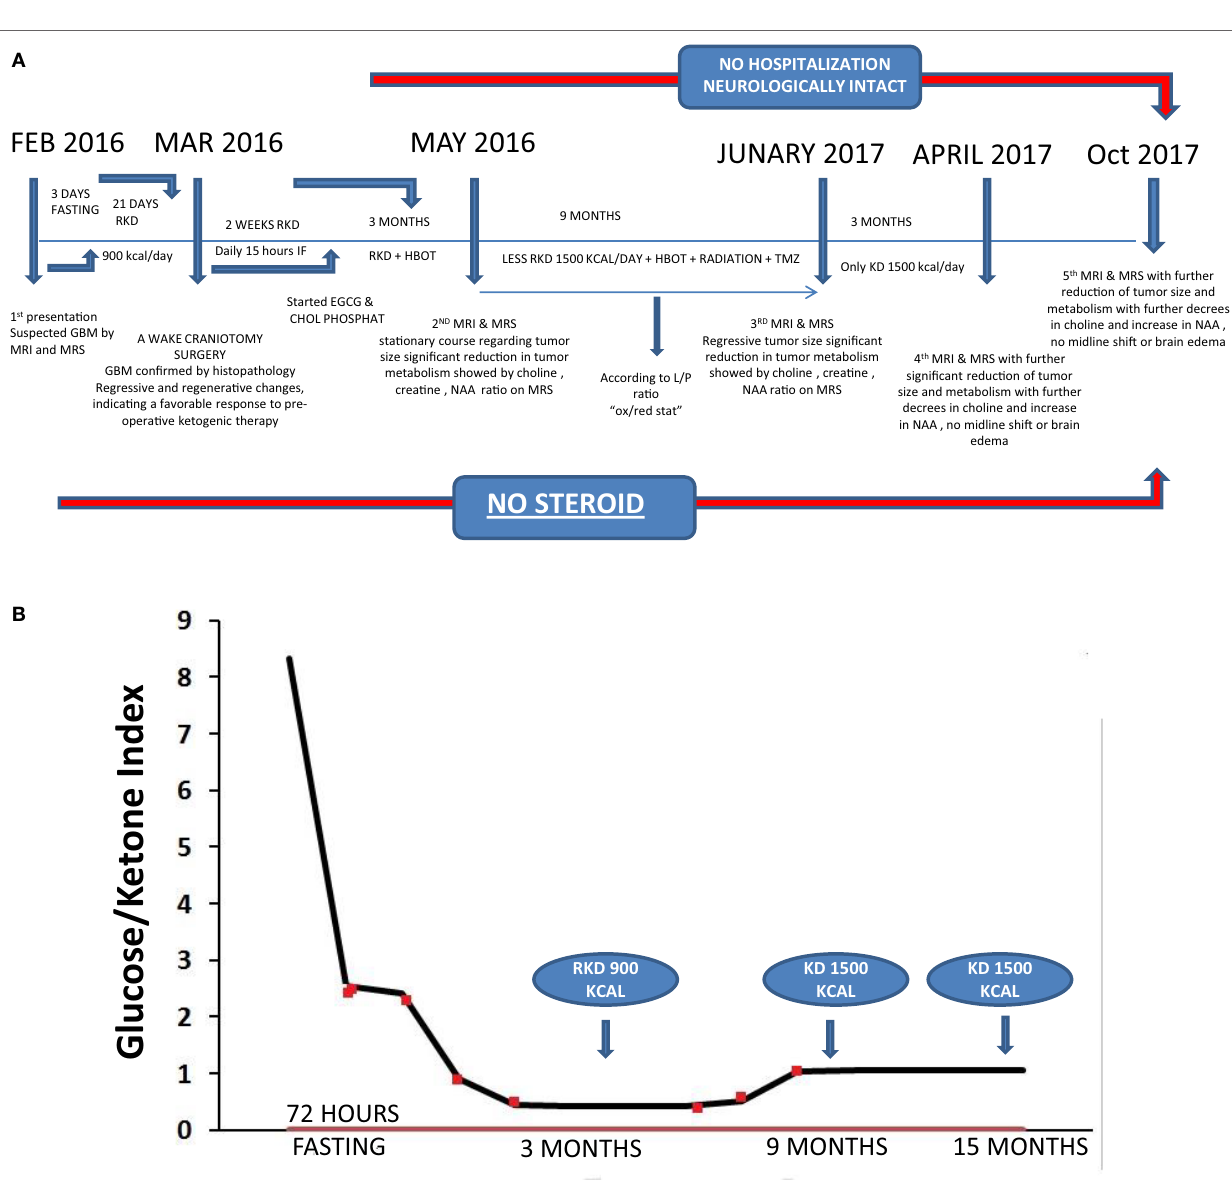
FiGURe 1 | (a) Timeline of clinical course with dates of dietary treatments, magnetic resonance imaging (MRI), magnetic resonance spectroscopy (MRS), and hyperbaric oxygen therapy (HBOT). (B) Glucose/ketone index indicates the ratio of circulating glucose to urinary ketones at all eight clinical assessments during the 15 months period from February 2016 to April